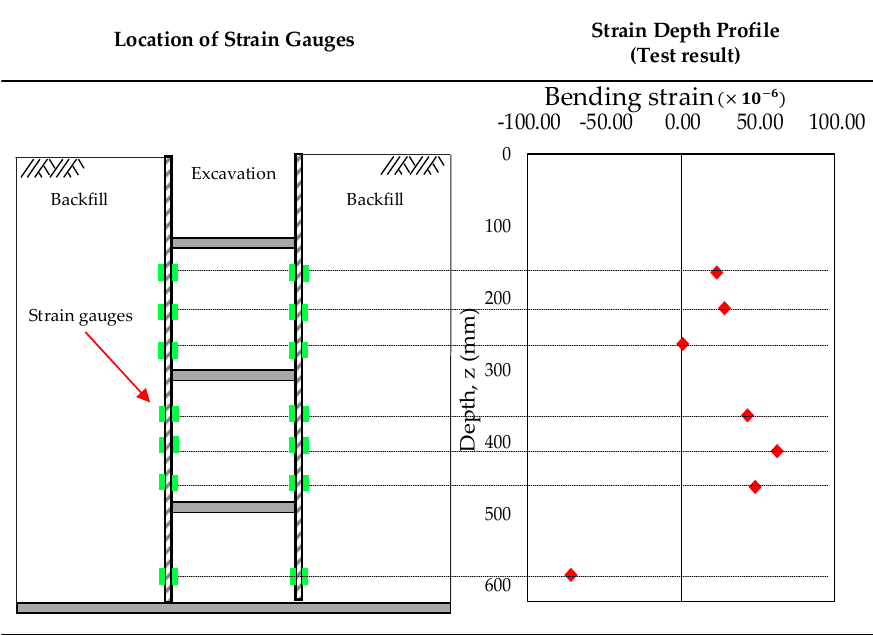
Figure 3. Centrifugal test result.